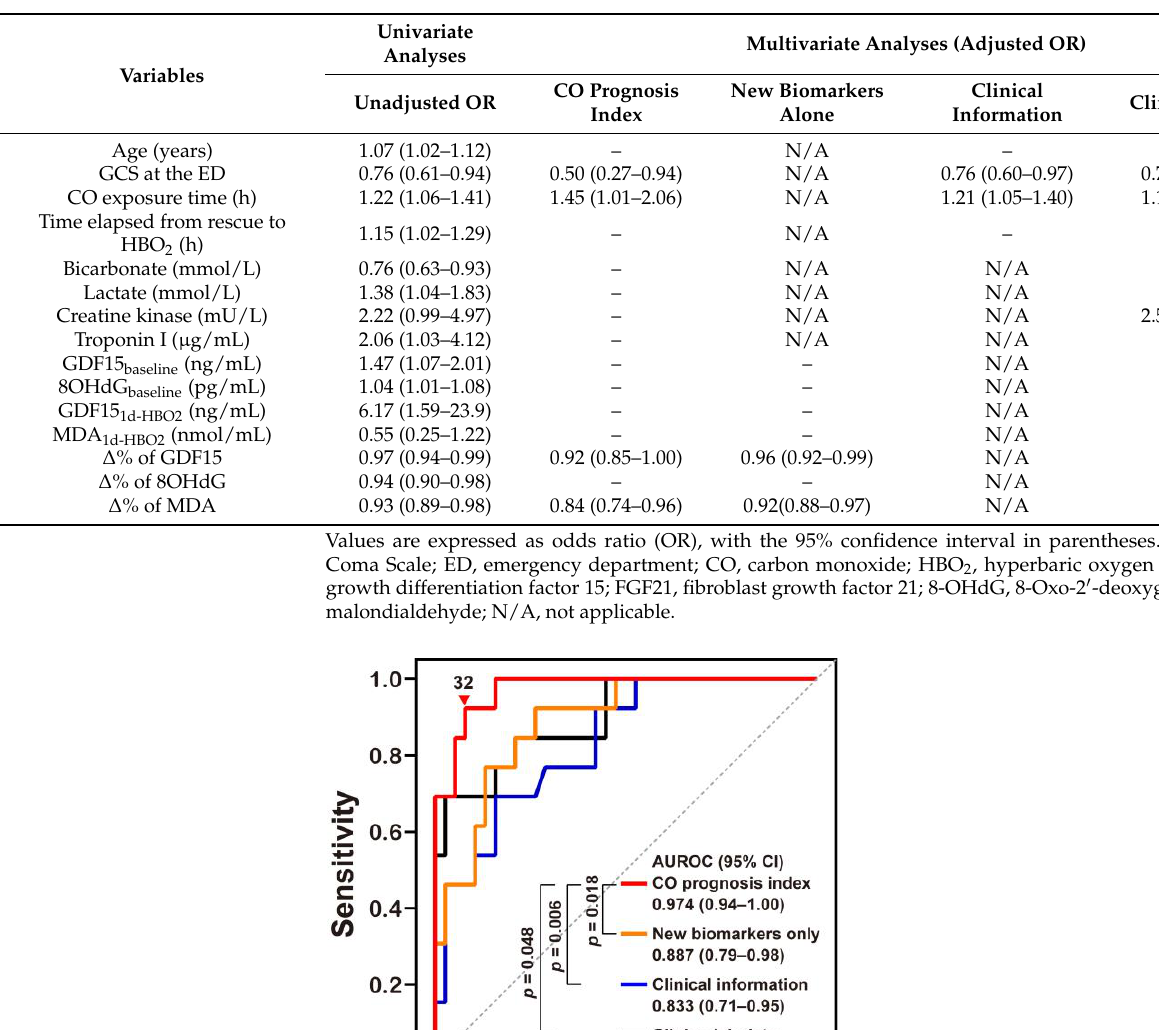
Table 3. Logistic regression analyses for predicting the neurocognitive outcome of post-CO poisoning.